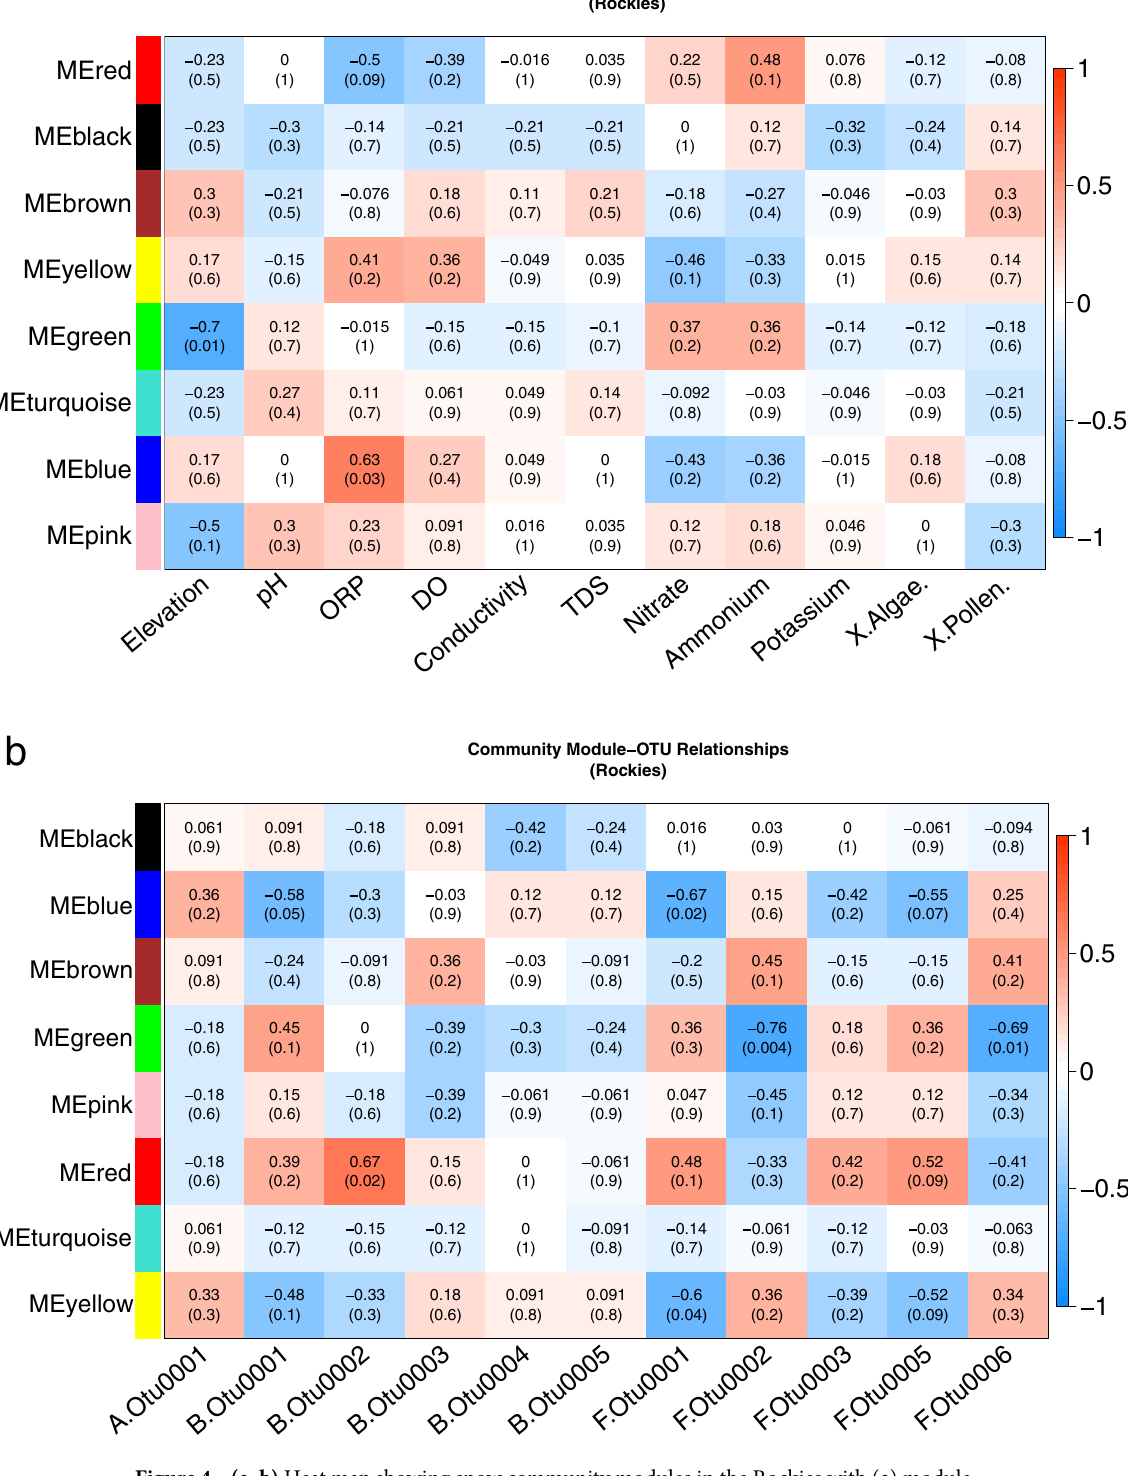
Figure 4. (a, b) Heat map showing snow community modules in the Rockies with ( a ) module- environment and ( b ) module-OTU correlations (Kendall-Tau). OTUs of interest were user selected and highly abundant. The upper value in each individual square is the correlation coefficient (with p-values parenthetical). Modules of the same color in different regions are not necessarily comprised of the same